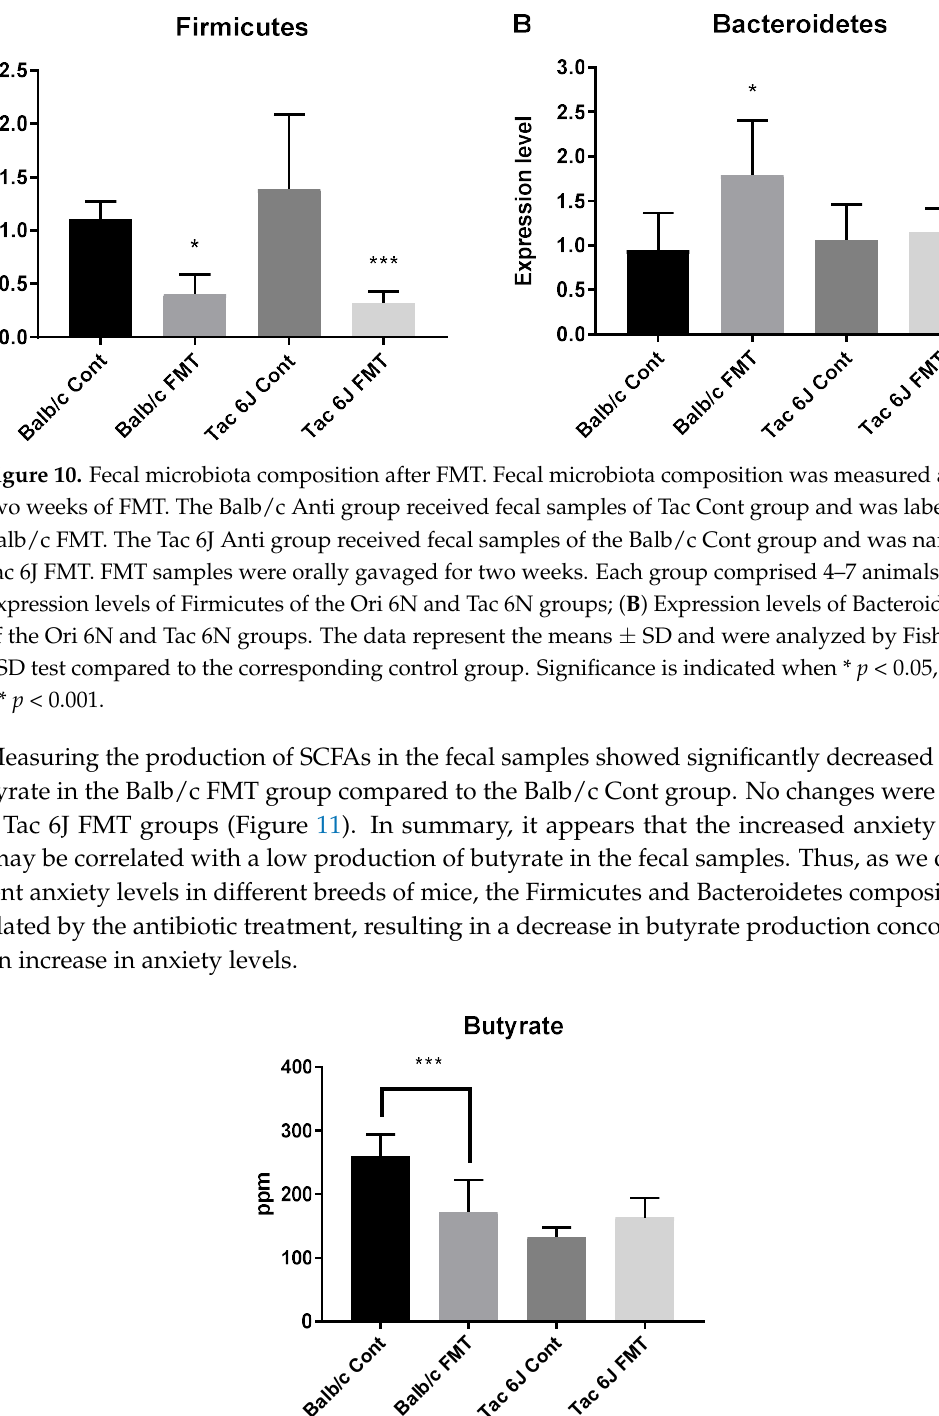
Figure 11. Butyrate production in fecal samples after FMT. The amount of butyrate in the fecal samples was measured by gas chromatography. The detection units for the butyrate is given as parts per million (ppm). The Balb/c Anti group received fecal samples of the Tac Cont group and was named Balb/c FMT. The Tac 6J Anti group received fecal samples of the Balb/c Cont group and was labelled Tac 6J FMT. FMT samples were orally gavaged for two weeks. Each group comprised 4-5 samples. The data represent the means ± SD and were analyzed by Fisher’s LSD test compared to the Balb/c Cont group. Significance is indicated when * p < 0.05, ** p < 0.01, and *** p < 0.001.